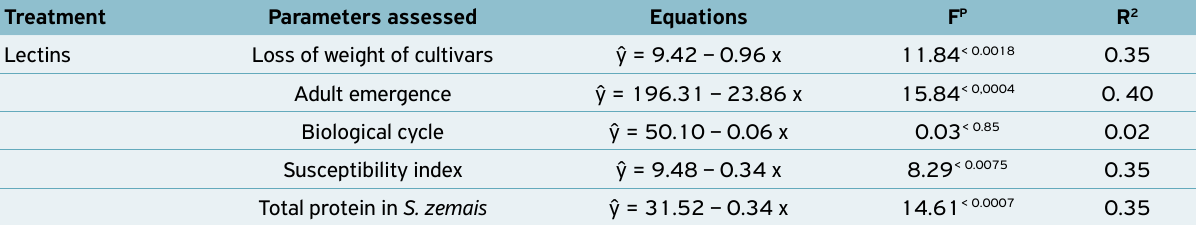
Table 2. Equations for loss of weight of cultivars, adult emergence, susceptibility index, biological cycle and total amount of total protein in Sitophilus zemais fed cultivars with different levels of lectins and their assessed parameters (F, Test Fisher, p, of the significance and value, R 2 , coefficient of